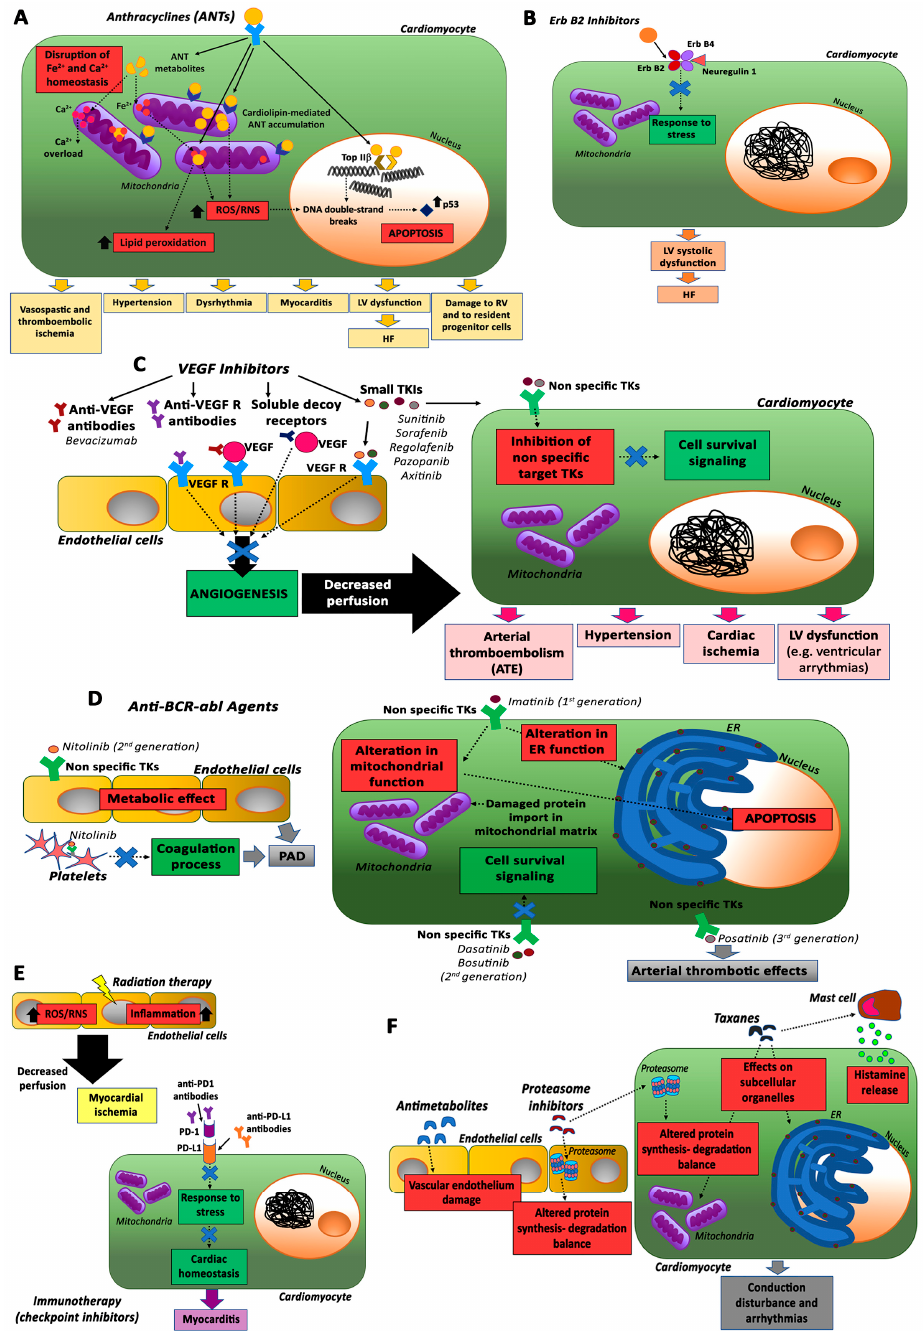
Figure 1. Mechanisms of cardiotoxicity induced by di ff erent classes of anticancer therapies. Treatment for cancer diseases can adversely a ff ect both the heart and the vasculature, leading to death of cardiomyocytes, endothelial dysfunction, and, consequently, di ff erent cardiovascular complications. Common cellular targets and pathways involved in cardiotoxicity linked to anthracyclines ( A ), ErbB2 inhibitors ( B ), VEGF inhibitors ( C ), anti-BCR-Abl agents ( D ), radiation therapy and immunotherapy (in particular checkpoint inhibitors) ( E ), and other commonly used, less specific antineoplastic drugs (antimetabolites, proteasome inhibitors, and taxanes) ( F ) are schematically illustrated. Abbreviations: ANTs, anthracyclines; TopII β , topoisomerase II β ; ROS, reactive oxygen species; RNS, reactive nitrogen species; LV, left ventricular; RV, right ventricular; HF, heart failure; ErbB2 / ErbB4, human epidermal growth factor receptor 2 / 4; VEGF, vascular endothelial growth factor; R, receptor; TKs, tyrosine kinases; TKIs, tyrosine kinase inhibitors; ER, endoplasmic reticulum; PAD, peripheral artery disease; PD-1, programmed cell death protein 1; PD-L1, programmed cell death protein ligand